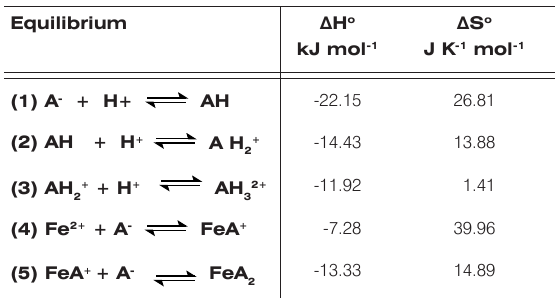
Table 3. Formation constants of Fe(II)-BIMP complexes of general formula Fe strength 0.1 M NaNO System